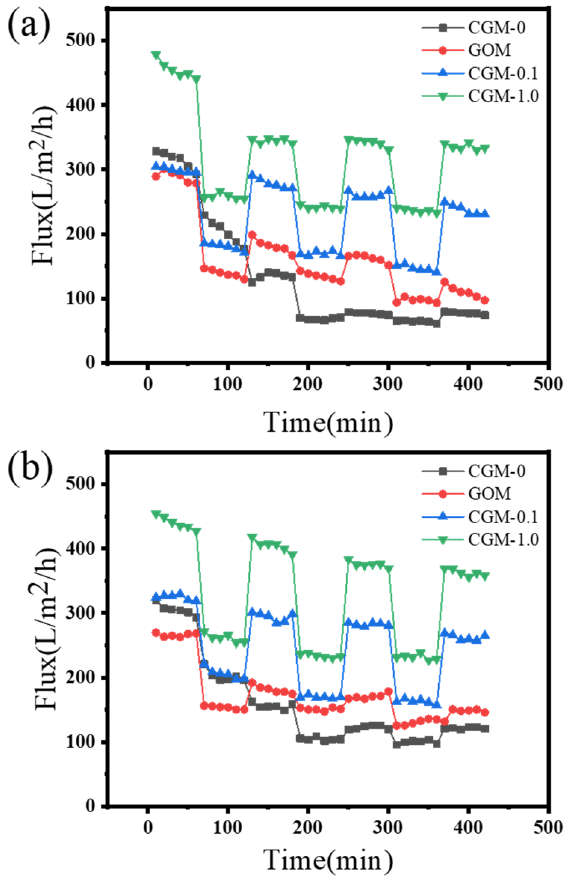
Figure 12. Water flux recovery of CGM-0, GOM, CGM-0.1 and CGM-1.0 after 3 cycles of BSA solution ( a ) and HA solution ( b ).